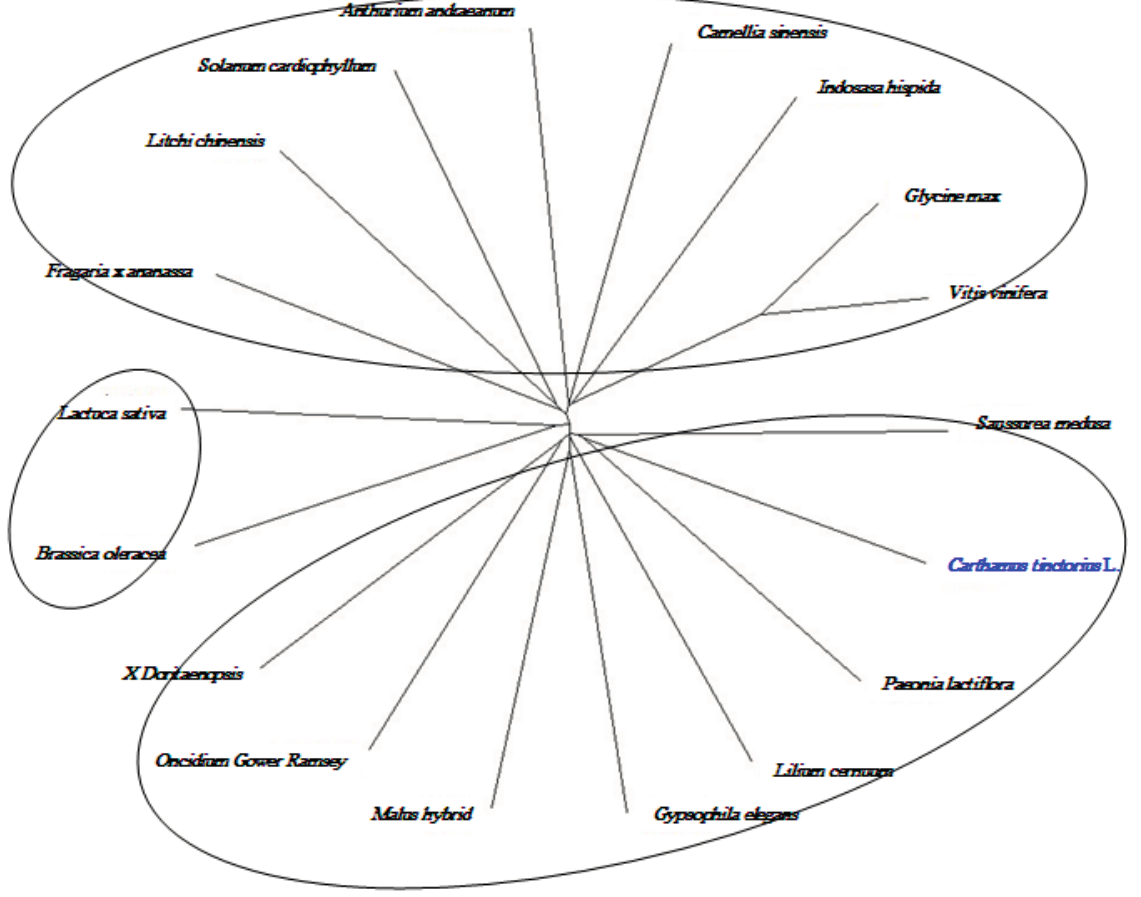
Figure 13. The amino acid sequence of anthocyanidin synthase ( ANS ) gene of safflower. It encoded a polypeptide of 349 amino acids.